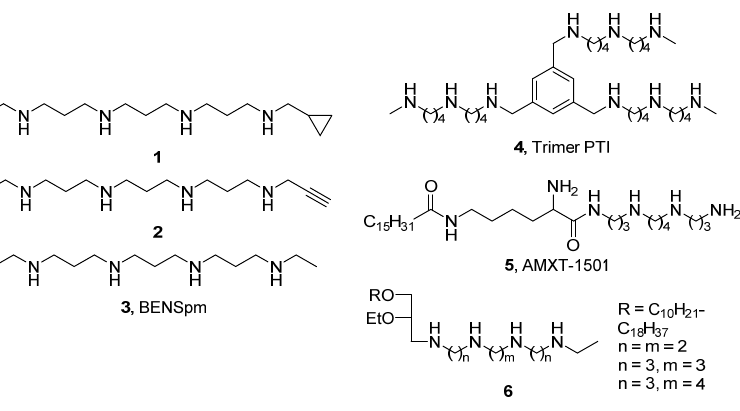
Figure 1. Synthetic PAs with anticancer